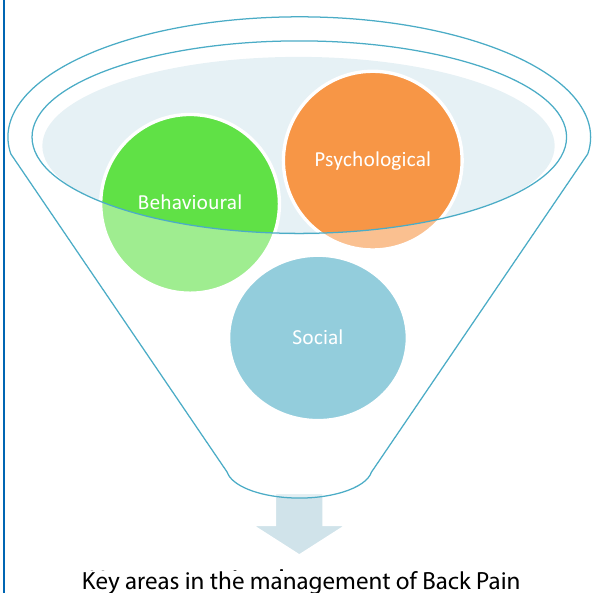
Figure 2: Key areas to consider in the management of back pain In the past few decades, emphasis on self-management, physical and psychological therapy has taken precedence over pharmacological treatment and surgery. Non-pharmacological methods are the first line and if unsuccessful, pharmacological treatments are used 16